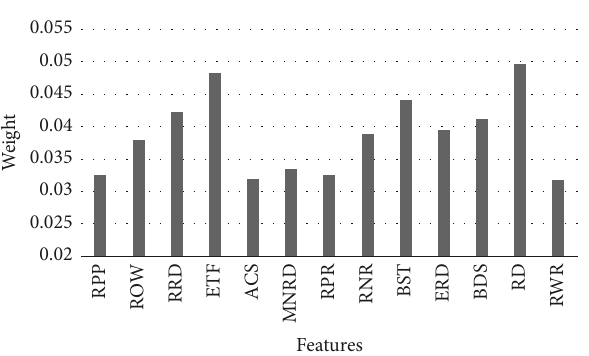
Figure 10: Features weight distribution of YelpNYC.